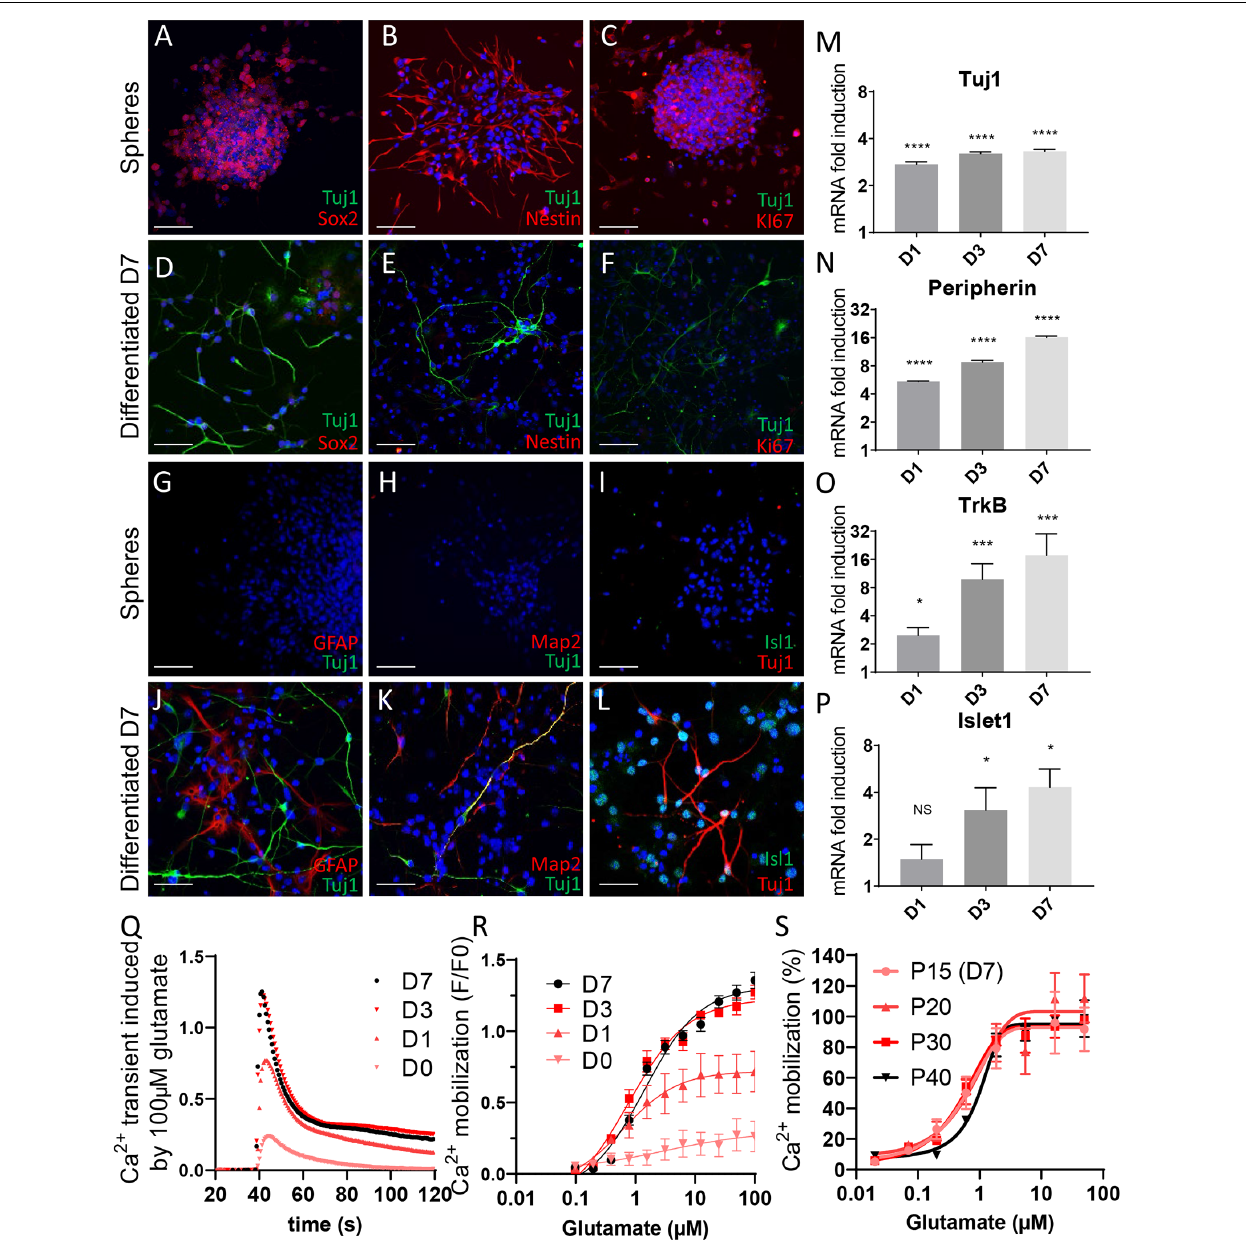
FIGURE 5 | Phenotypical characterization of phoenix auditory neurons. (A–F) Three days following passaging, neurospheres were plated on Matrigel-coated coverslips. (A–C) Four hours following the plating, neuroprogenitor spheres were fixed, permeabilized, and stained for the indicated markers. (D–F) Seven days’ differentiated auditory neurons were used as control. (A,D) BIII-tubulin and Sox2 in neuroprogenitors and differentiated cells. (B,E) BIII-tubulin and nestin in neuroprogenitors and differentiated cells. (C,F) BIII-tubulin and KI67 in neuroprogenitor spheres and differentiated auditory neurons. Scale bar: 50 µ m. Isolated phoenix auditory neuroprogenitors were differentiated on Matrigel-coated (G–L) coverslips for immunofluorescence experiments, (M–P) six-well plates for qPCR experiments, or (Q–R) 96-well plates for Ca 2+ transients measurement for the indicated time points (1–7 days). (G–L) Seven days’ differentiated auditory neurons were fixed, permeabilized, and stained for the indicated markers. (G–I) Undifferentiated spheres of progenitors were used as control. (G,J) BIII-tubulin and astrocyte marker GFAP, (H,K) BIII-tubulin and mature neurons marker Map2, (I,L) BIII-tubulin and sensory neurons marker Isl1, (M–P) mRNA level of several auditory neuron markers such as (M) BIII-tubulin, (N) peripherin, (O) TrkB, and (P) Islet1 was assessed by qPCR during the differentiation process (after 1, 3, or 7 days of differentiation). Scale bar: 50 µ m. (Q,R) Phoenix auditory neurons were differentiated for the indicated times, loaded with Ca 2+ -sensitive ratiometric probe (FLUO-8), and stimulated with increasing concentrations of glutamate (0.02–100 µ M). Traces represent (Q) maximum amplitudes ( F / F 0 ) in response to 100 µ M glutamate and (R) dose–response curves, as recorded along the differentiation process at different time points (after 1, 3, or 7 days of differentiation). (S) Glutamate dose–response induced Ca 2+ mobilization in D7 differentiated phoenix auditory neurons as recorded at different passages (from P15 to P40). Data represent the average ± SEM of three independent experiments. * p < 0.05, *** p < 0.005, **** p < 0.0005, NS: non significant.